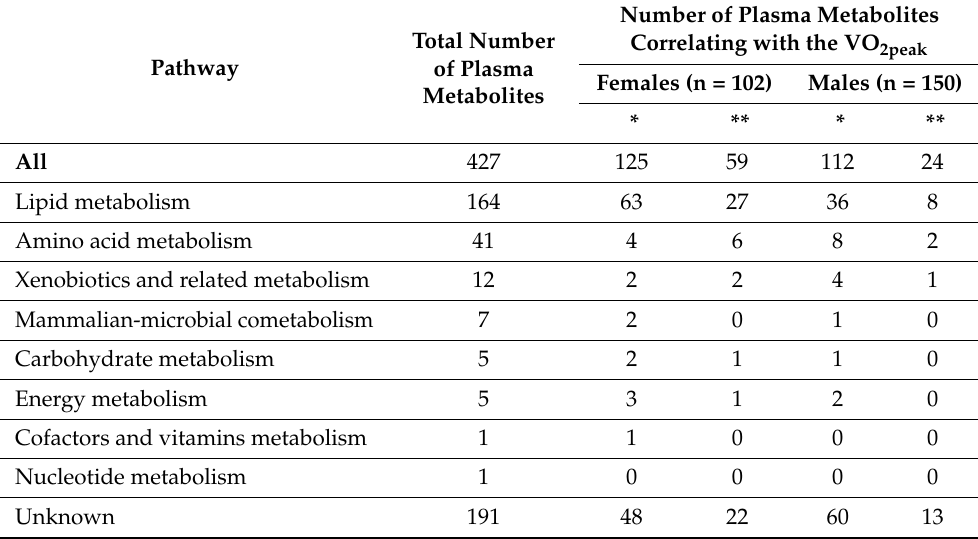
Table 1. The number of detected plasma metabolites, according to major metabolic pathways, and number of metabolites significantly correlating with the VO 2peak , shown separately by sex. Number of Plasma Metabolites Total Number Correlating with the VO 2peak Pathway of Plasma Females (n = 102) Males (n = Metabolites